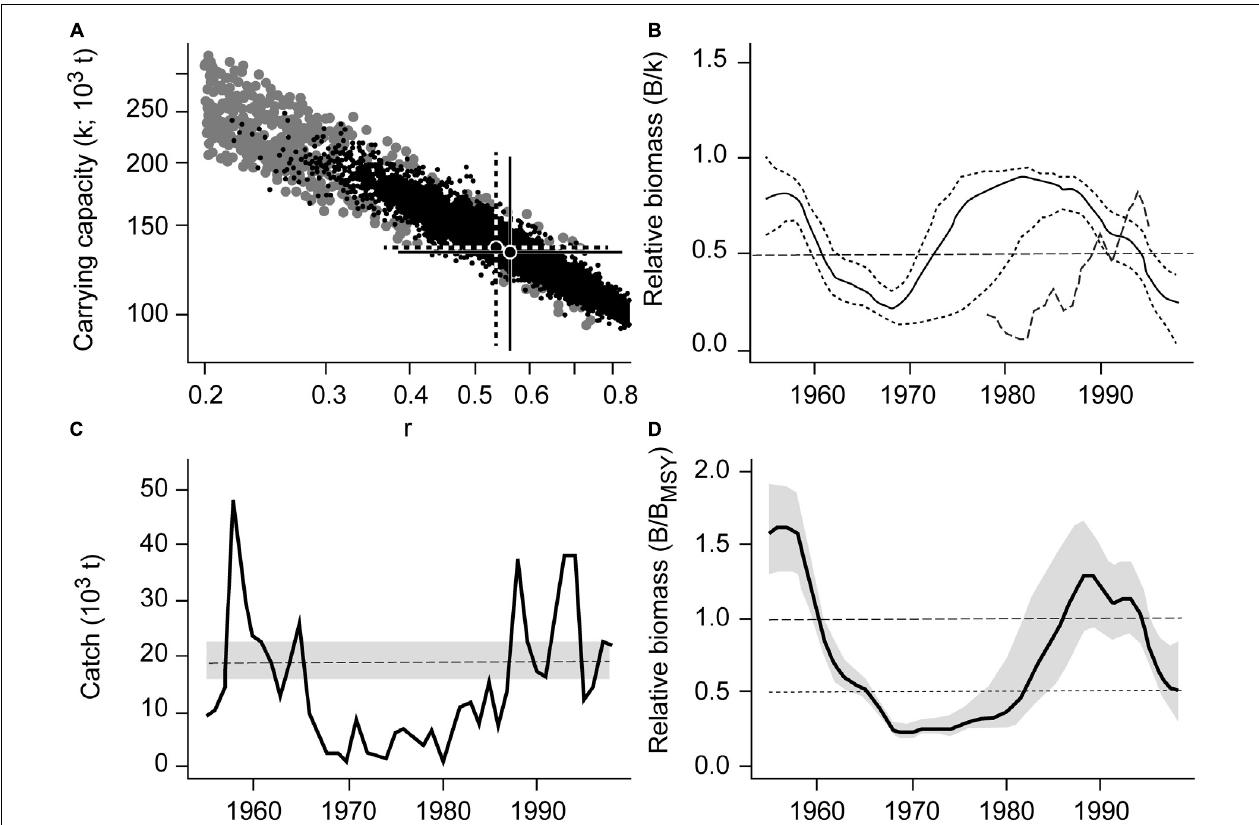
FIGURE 1 | Results of the CMSY and BSM analyses for the Japanese jack mackerel ( Trachurus japonicus ) in South Korean waters. (A) viable r-k pairs identified by the CMSY and BSM methods. (B) Biomass trajectory estimated by CMSY (solid black line), with the two dotted lines being its CIs, and available abundance data scaled to the BSM estimate of k (broken line). (C) Catches relative to the BSM estimate of MSY, with the 95% confidence interval in gray. (D) Estimated relative biomass trajectory ( B/B MSY ), with the gray area indicating the confidence